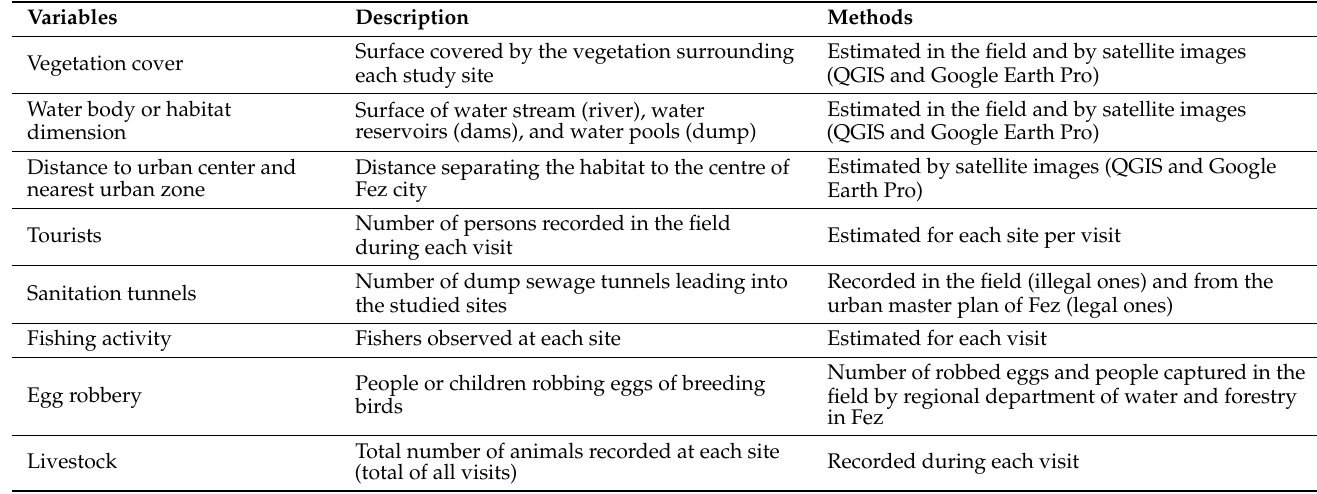
Table 1. Natural and anthropic factors recorded in study